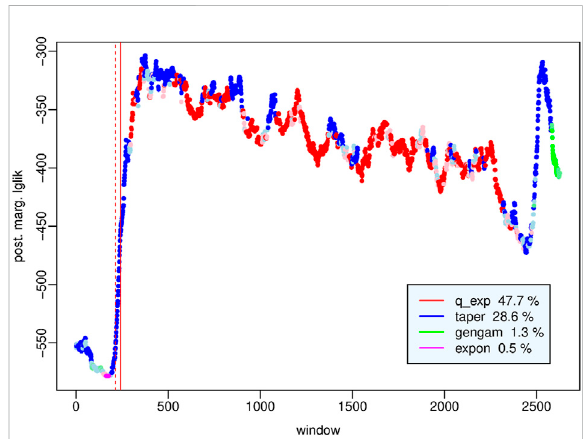
FIGURE 3 L ’ Aquila sequence - Magni fi cation of Figure 2 in the